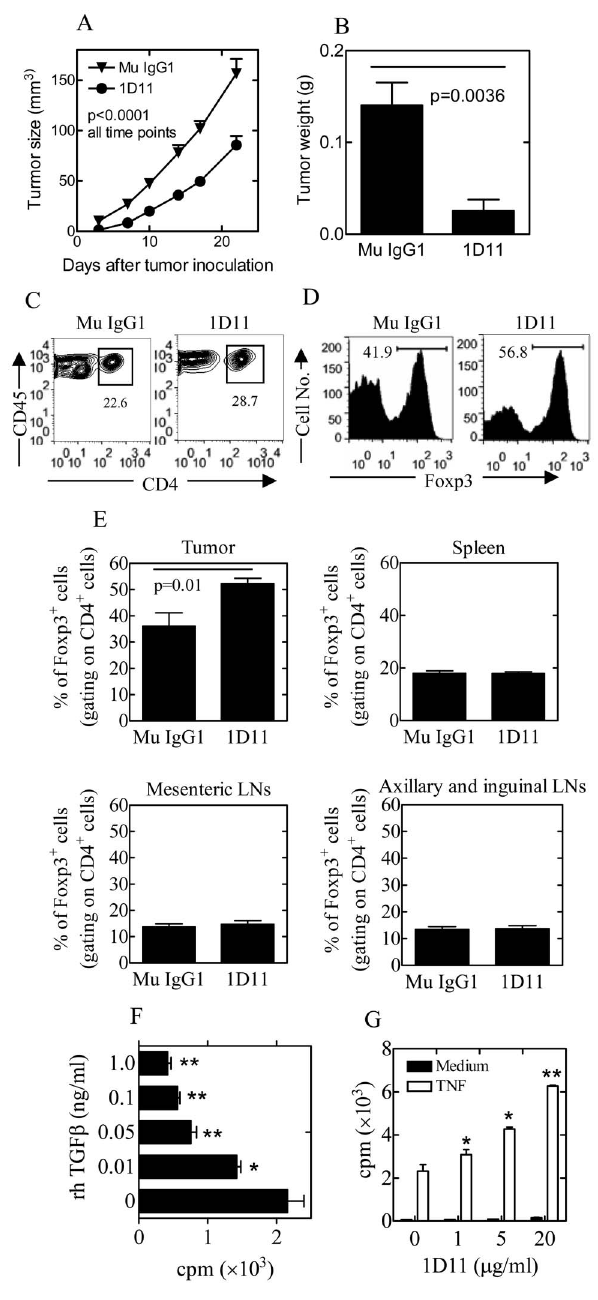
Figure 1. Effects of 1D11 on 4T1 tumor growth and on the expansion of Tregs in vivo and in vitro. (A-D) Mice were treated with 0.1 mg 1D11 or mouse IgG1 (i.p., 3 6 week), starting at day 1 of tumor inoculation. (A) Kinetics of tumor growth. (B) Weight of